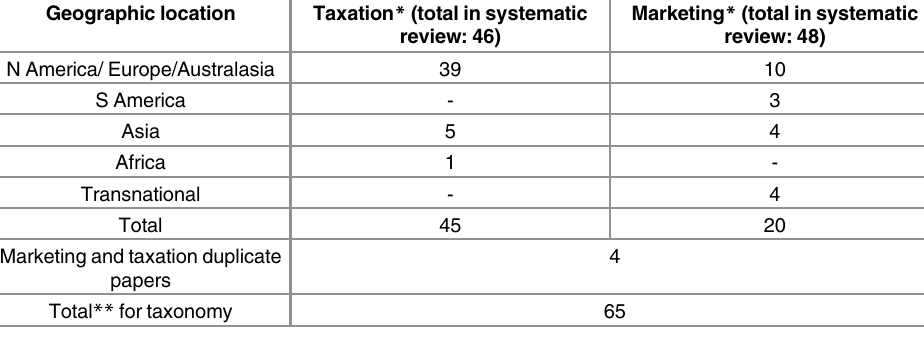
Table 1. The number of papers from the two systematic reviews included in the analysis by geo- graphic location and topic. Geographic